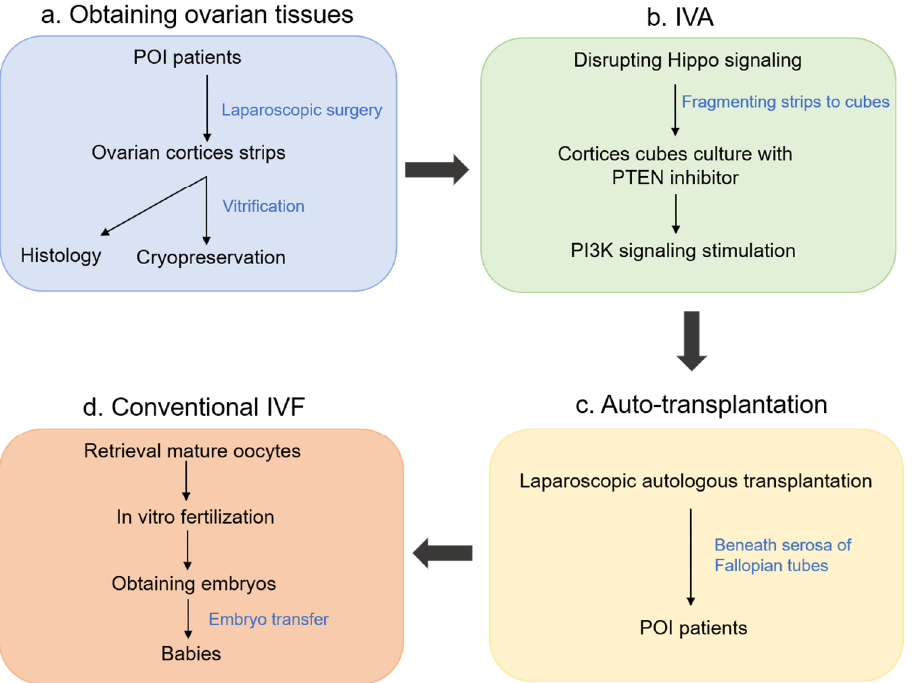
Figure 4. Schematic diagram of IVA. ( a ) Obtaining ovarian tissues. Under laparoscopic surgery, ovaries were obtained and cut into strips for histology and cryopreservation after vitrification. ( b ) IVA. After thawing of cryopreserved ovarian strips, the strips were fragmented into 1–2 mm 3 cubes and cultured with Akt stimulators for 2 days. ( c ) Auto-transplantation. After two days of culture, the ovarian cubes were autografted beneath the serosa of the fallopian tubes. ( d ) Conventional IVF. Follicle growth was stimulated by injection of FSH. When preovulatory follicles were found, mature oocytes were retrieved for IVF to obtain embryos.